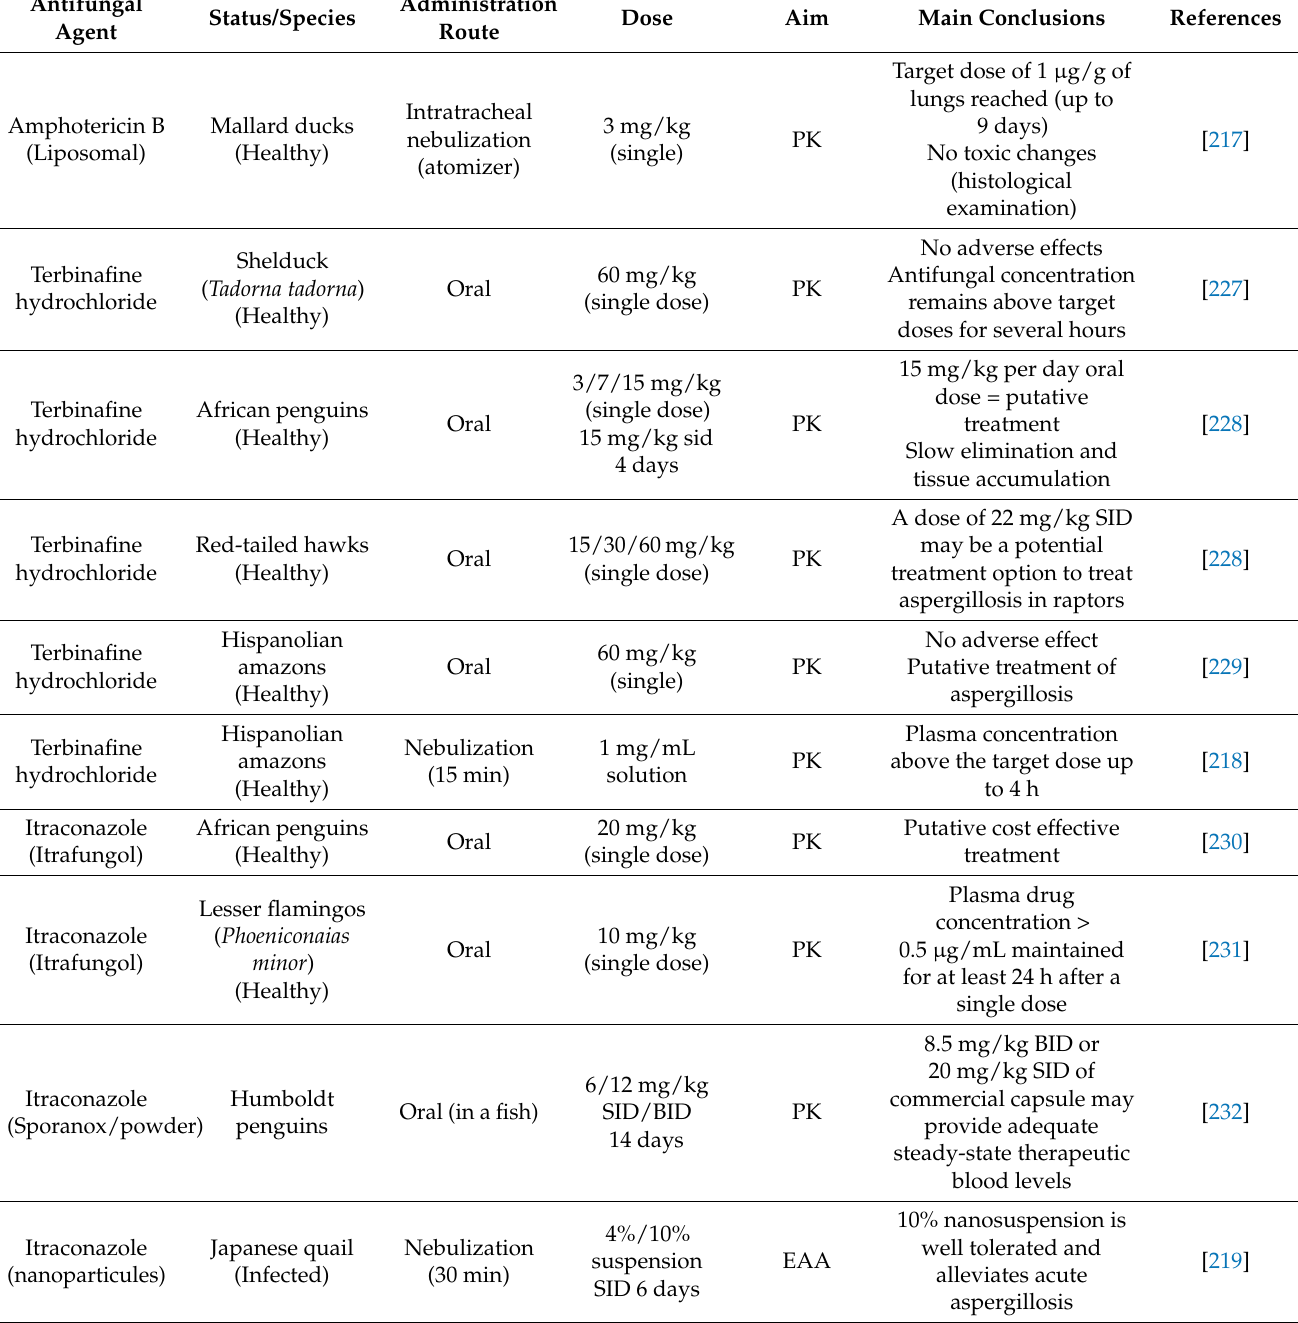
Table 3. Bioavailability and efficacy of different antifungal agents tested experimentally in several avian